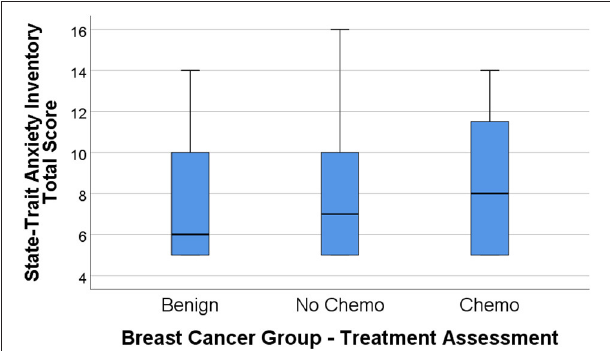
FIGURE 1 | State-Trait Anxiety Inventory (STAI) total score box plots for the benign (breast lump autopsy), no-chemo (treatment for breast cancer), and chemo (treatment for breast cancer) groups. Higher scores mean greater total anxiety, with the median group value-line bisecting the box, top and bottom of the box representing 3rd and 1st percentile, and upper-value range of scores capped above the box.